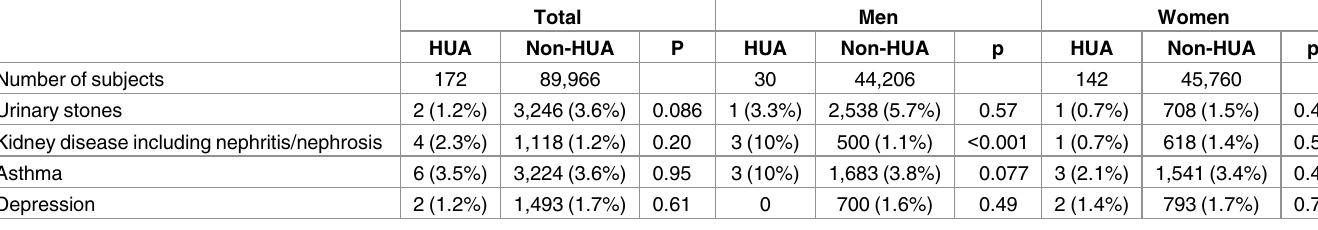
Table 3. The differences of medical history between hypouricemia and